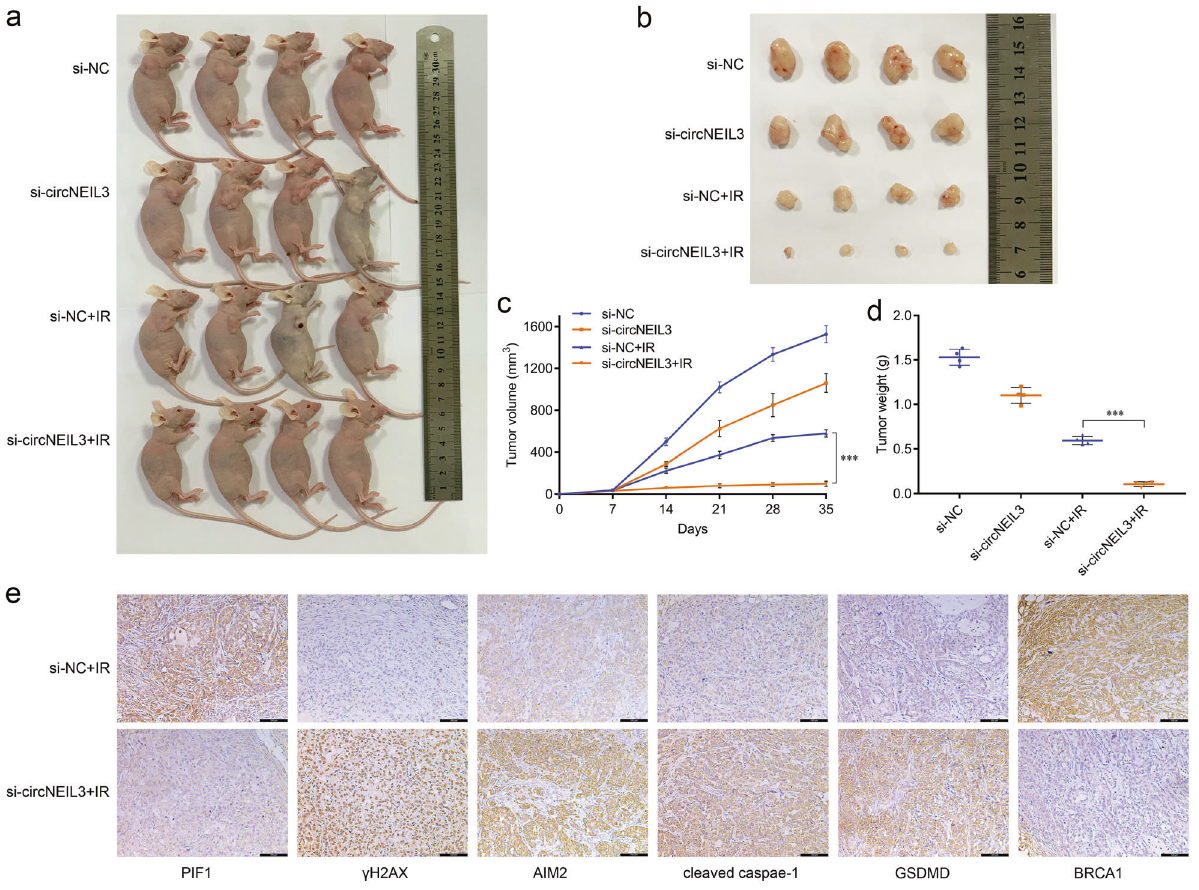
Fig. 7 circNEIL3 knockdown promotes the radiation ef fi ciency in vivo. a Images of nude mice with subcutaneous xenografts in the indicated groups. b Xenograft tumors isolated from sacri fi ced mice with or without radiation treatment (0 or 4 Gy/time/week) at the end of the experiment. c Volumes of subcutaneous xenograft tumors. d Average weights of xenograft tumors in the indicated groups. e Immunohistochemistry staining of DNA damage and pyroptosis biomarkers in subcutaneous tumors of mice injected with si-NC + IR vs si- circNEIL3 + IR (scale bar, 100 μ m).